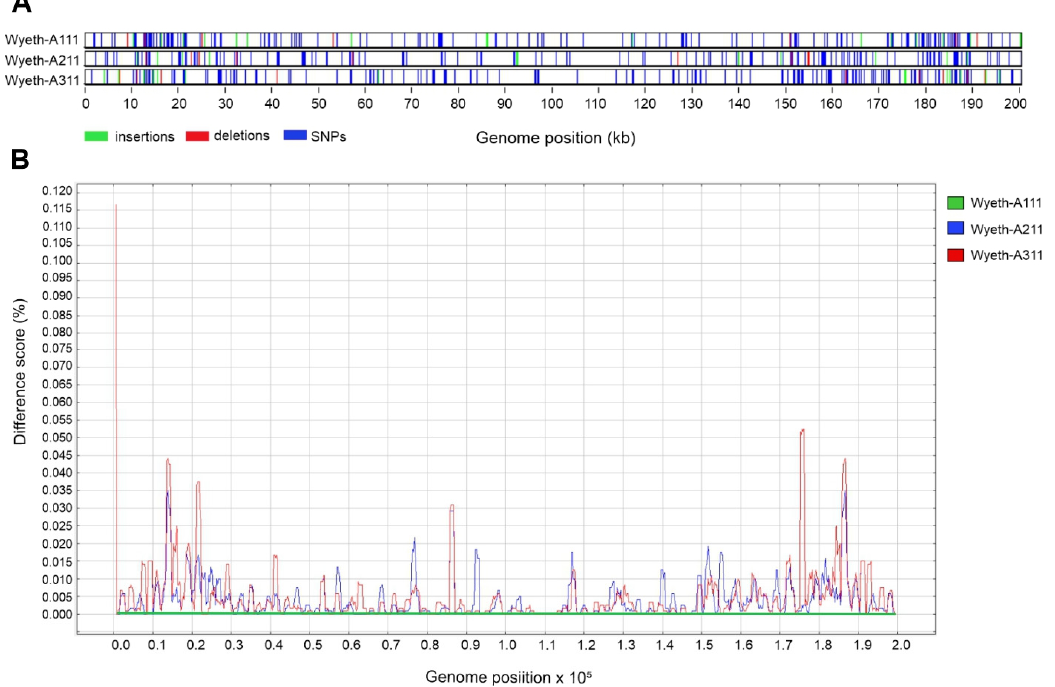
Figure 2. Genome-wide analysis of differences comparing the genomes of VACV-Wyeth clones A111, A211, and A311. The full-genome alignment of VACV-Wyeth clones A111, A211, and A311 was analyzed using Base-by-base [29]. ( A ) A graphical presentation of sequence variations per site (SNPs and INDELs) was revealed by pairwise comparison of the three Wyeth genomes. ( B ) Differences per site detected in the genomes of clones A211 (red line) and A311 (blue line) in relation to clone A111 (green bottom line) were scored along the